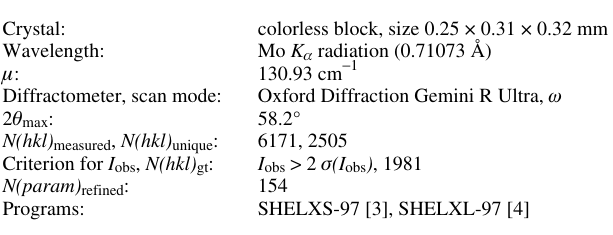
Table 1. Data collection and handling.